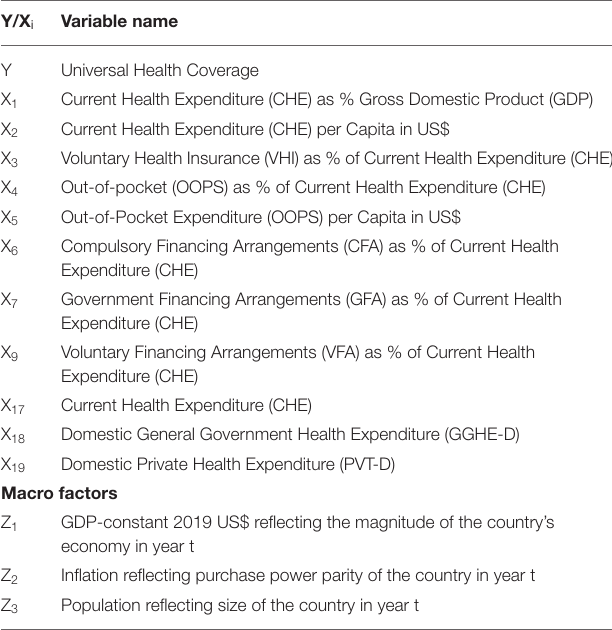
TABLE 1 | Details of Output (Y ijt ) and Inputs (X ijt and Z ijt